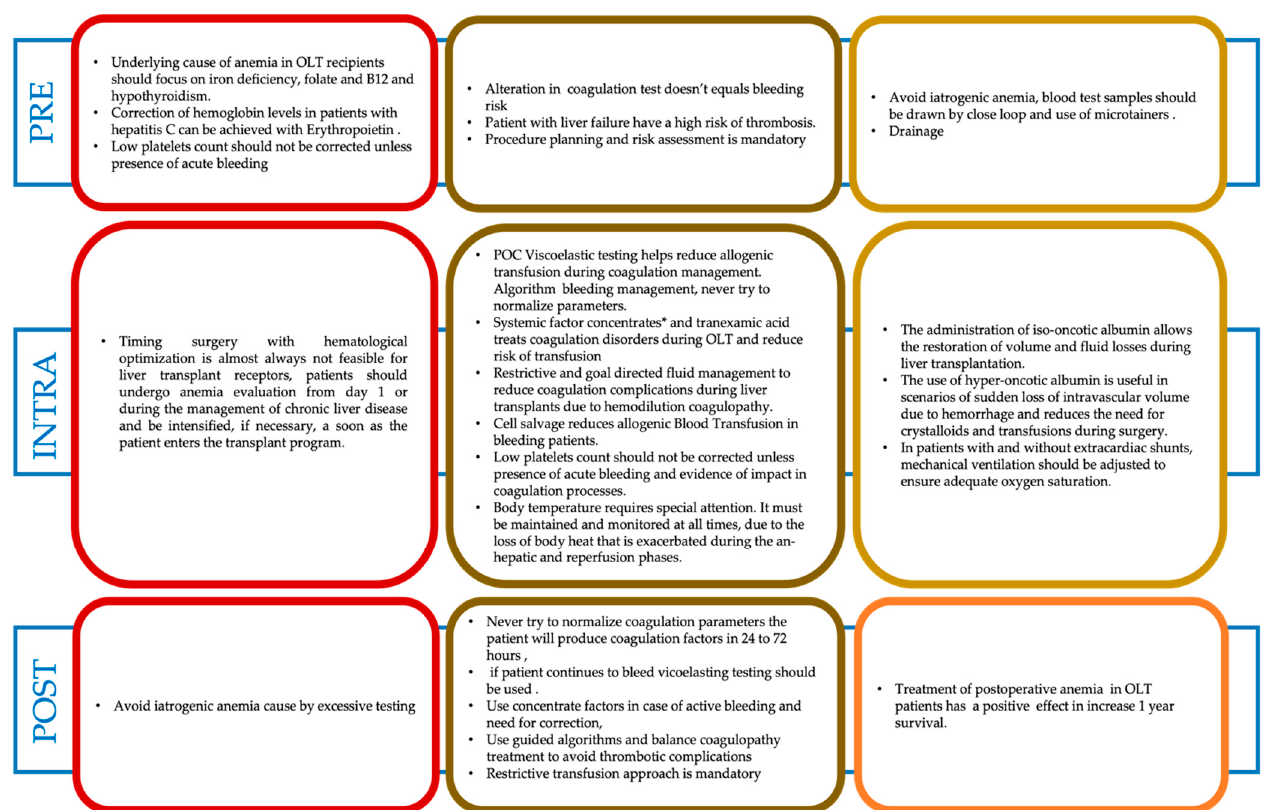
Figure 1. The three-pillar nine-field matrix of patient blood management in liver transplant recipients. Liver transplant recipients have a high incidence of anemia prior to